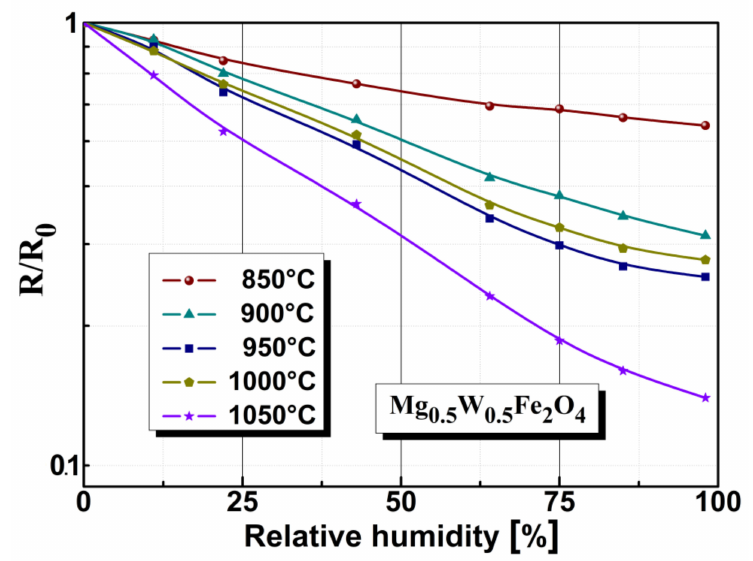
Figure 10. Electrical of sensors based on Mg 0.5 W 0.5 Fe 2 O 4 ferrite material annealed at various